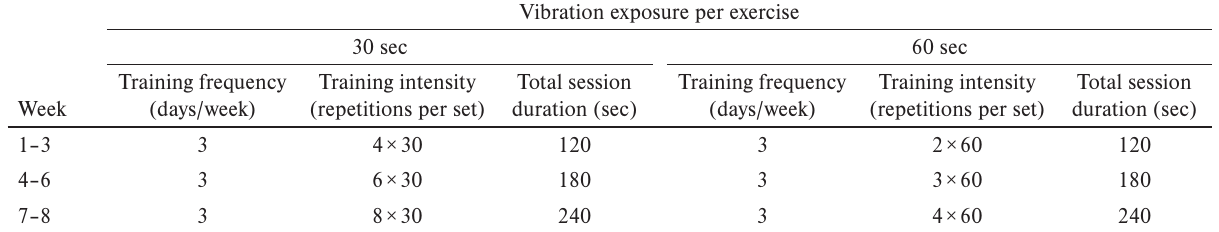
Training volume and training intensity of the WBV